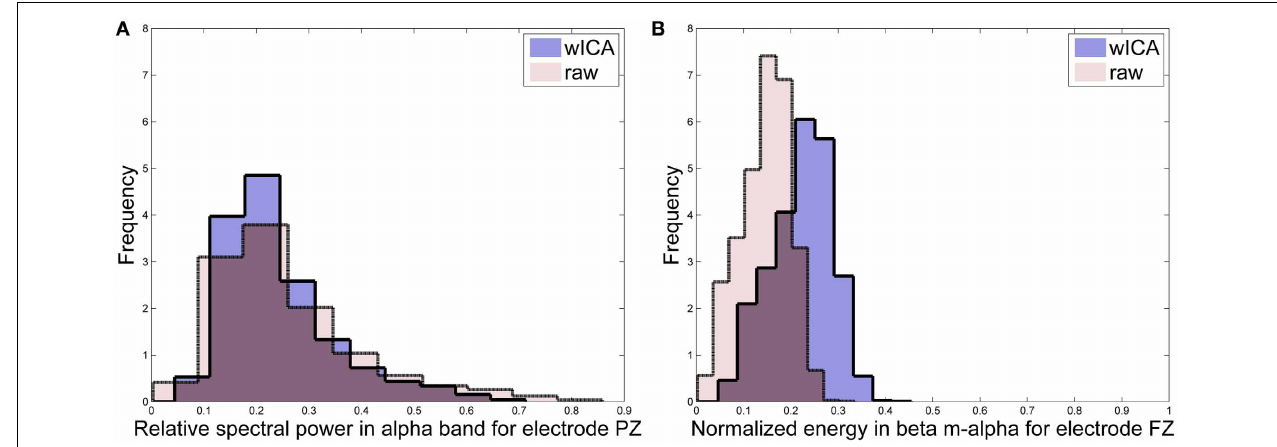
FIGURE 2 | Histograms for features (A) PZ_alpha_pwr and (B)